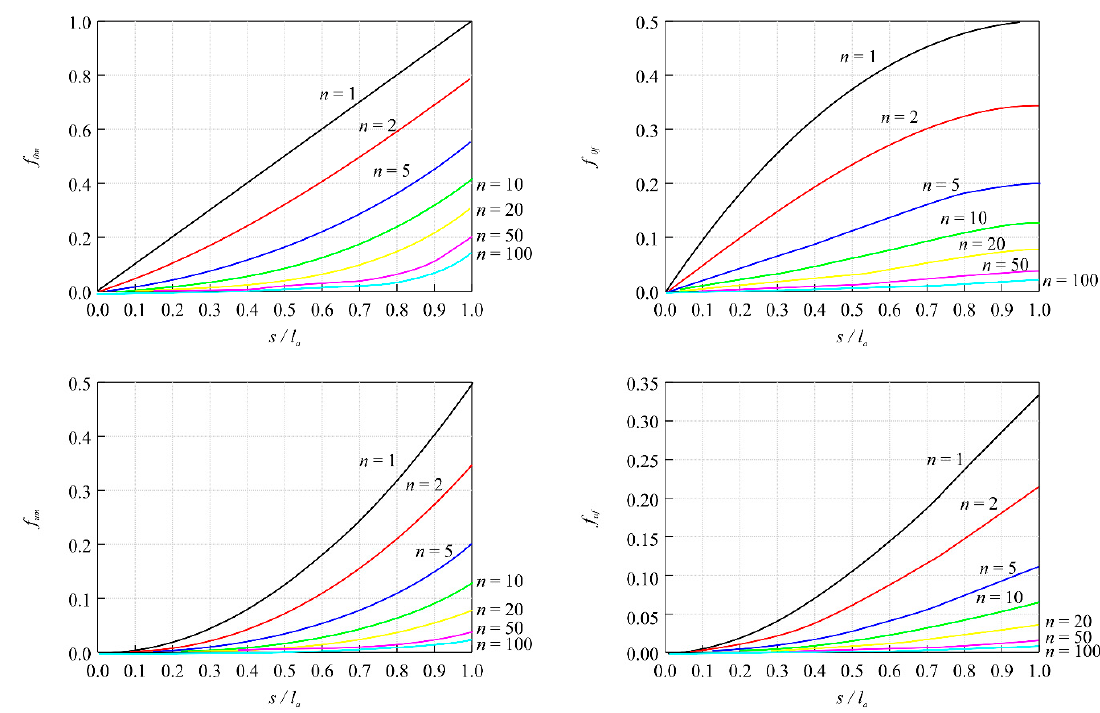
Figure 13. Characteristics of f -factors with variation of n.